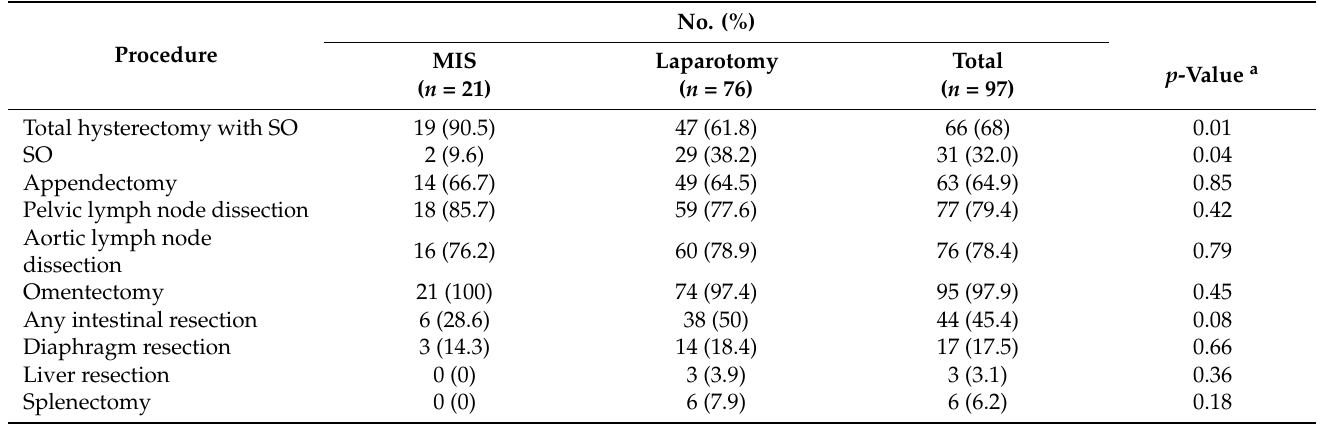
Table 5. Comparison of procedures for the primary debulking group.